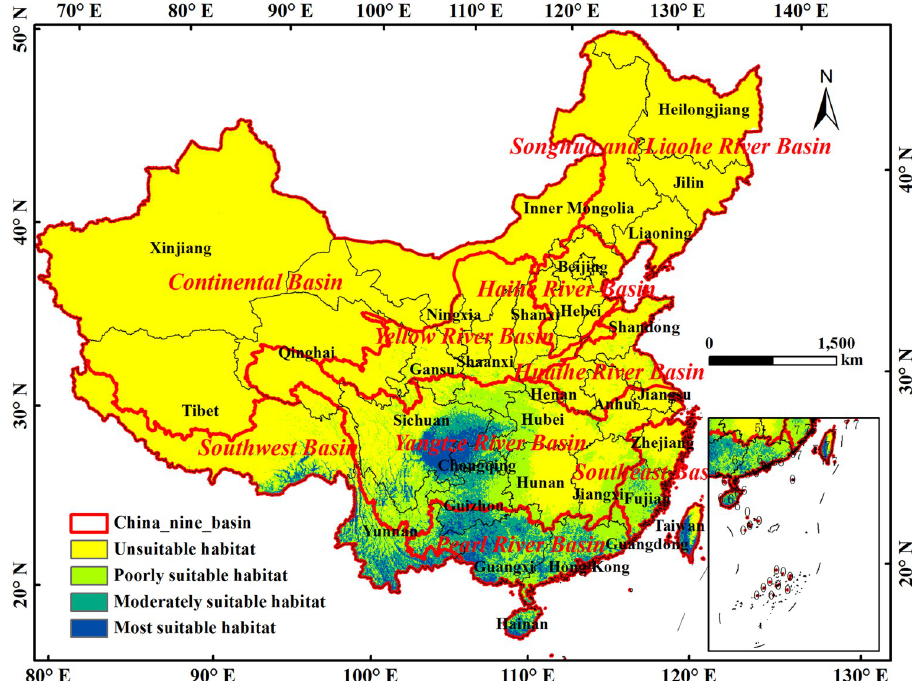
Fig 2. Suitable habitat simulated by MaxEnt under current climate situation. The boundary was obtained from Natural Earth (http://www.naturalearthdata.com/). Based on the principle of national and territorial integrity, we have modified and adjusted the vector